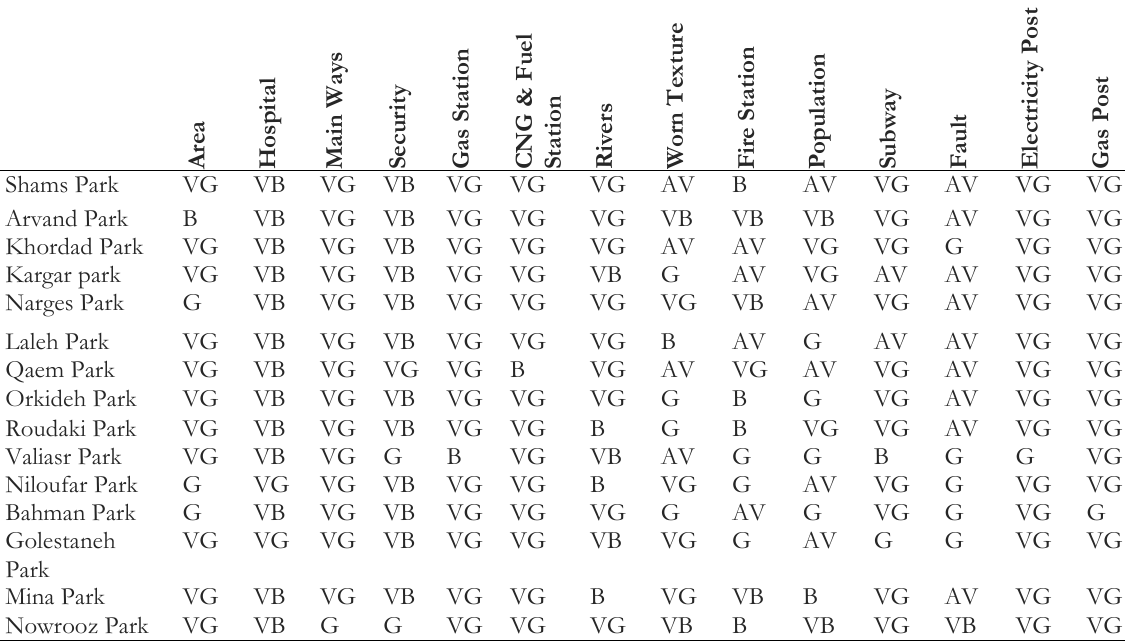
Table 3. Results for places relative to